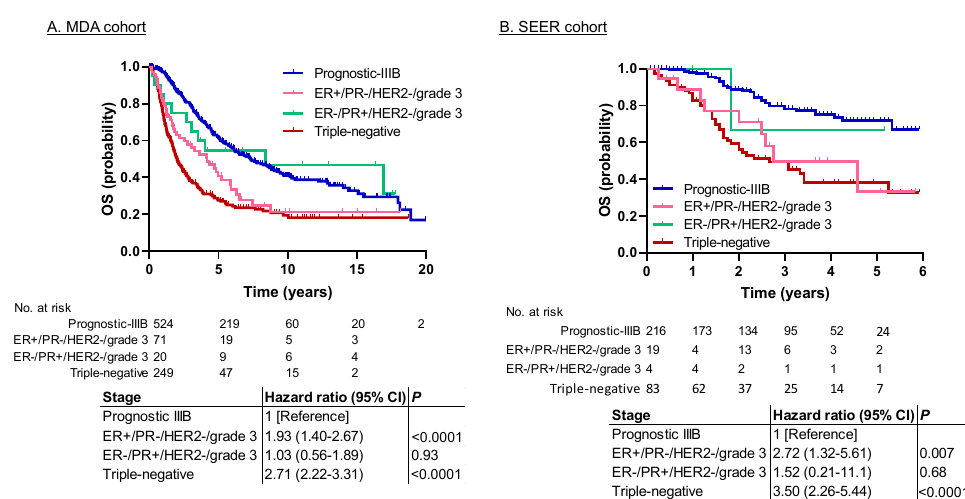
Figure 4. Survival analysis of prognostic stage IIIB and subgroups of prognostic stage IIIC for OS in the ( A ) MDA cohort and the ( B ) SEER cohort. The OS for ER +/ PR − / HER2 − / grade 3 and ER − / PR +/ HER2 − / grade 3 was better than that for triple-negative IBC and worse than that for prognostic stage IIIB in both cohorts. Abbreviations: ER, estrogen receptor; HER2, human epidermal growth factor receptor 2; OS, overall survival; PR, progesterone receptor.